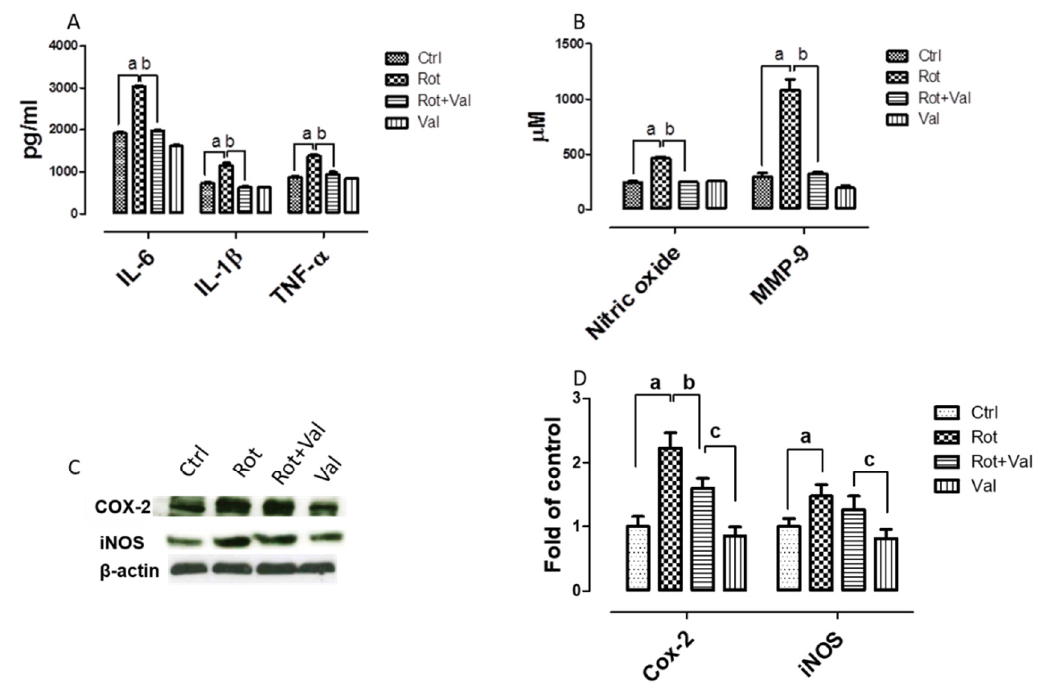
Figure 2. Valeric acid prevented nitric oxide production and alters expression of inflammatory factors in rotenone treated animals. Enzyme linked Immunosorbent assay showed that rotenone administration increased the expression of pro-inflammatory cytokines ( A ) and enhanced production of NO and MMP-9 ( B ). Immunoblots of midbrain protein samples probed with Cox-2 and iNOS ( C ). Blots were quantified using Image J and corresponding results were represented as bar diagram ( D ). However, Val treatment caused a significant decrease in expression and production of pro-inflammatory factors in rotenone intoxicated animals. Data are expressed as mean ± SEM. a p < 0.05 compared to control, b p < 0.05 compared to rotenone treated group, c p < 0.05 compared to Rot + Val treated group.